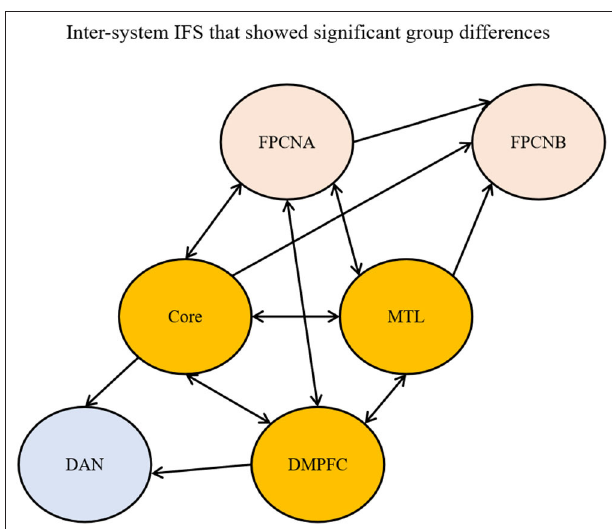
FIGURE 5 | Inter-subsystem IFS showing significant group differences ( p < 0.01). A single arrow indicates that the unidirectional connection between networks was decreased in AD. Double arrows indicate that the reciprocal connections between networks were decreased in AD. FPCNA, frontoparietal control network A; FPCNB, frontoparietal control network B; DM, dorsomedial prefrontal cortex; MTL, medial temporal lobe subsystem; DAN, dorsal attention